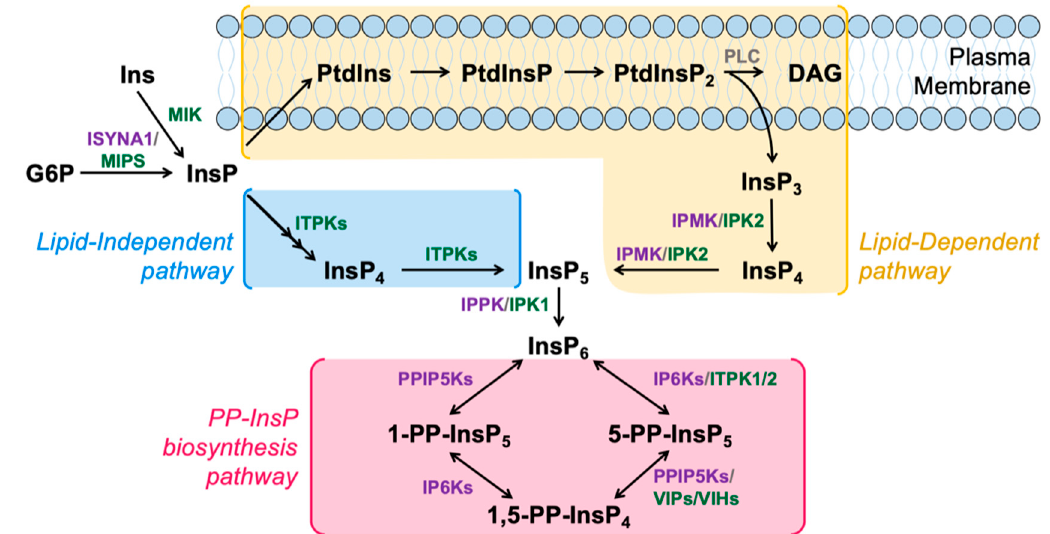
Figure 1. Schematic model of InsP and PP-InsP metabolism in humans and plants. InsPs are synthesized through the Lipid-Dependent (yellow) or Lipid-Independent (blue) pathways. PP-InsPs are synthesized from InsP 6 via the PP-InsP biosynthesis pathway (pink). Key enzymes in the InsP and PP-InsP pathways conserved in animals and plants (grey), specific to animals (purple) or specific to plants (green) are shown next to their respective reactions. Enzyme names are defined in the